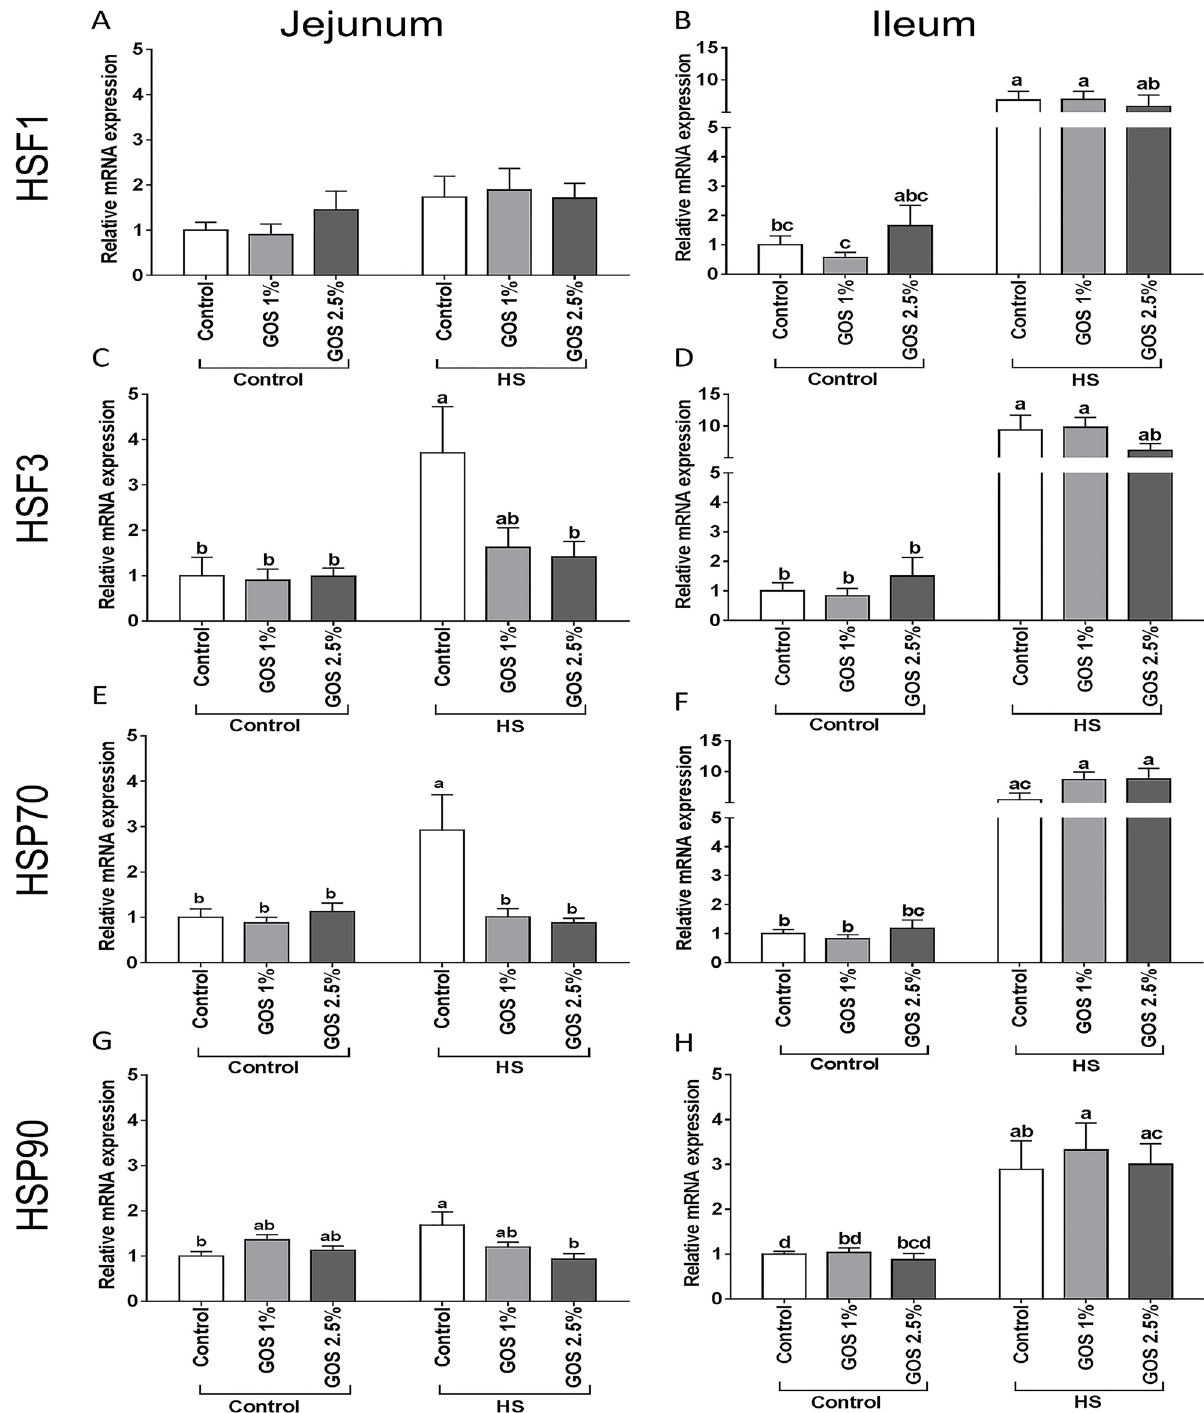
Fig 1. The effect of heat stress exposure on the mRNA expression of HSFs and HSPs in jejunum and ileum of chickens fed a control or GOS diet. Chickens fed a control or GOS (1 or 2.5%) diet for 6 days before being exposed to either control or heat stress conditions for 5 days. mRNA expression levels of HSF1 (A, B), HSF3 (C, D), HSP70 (E, F) and HSP90 (G, H) were evaluated in jejunum (A, C, E, G) and in ileum (B, D, F, H) by qRT-PCR. Results are expressed as relative mRNA expression (fold of control, normalized to β -actin) as mean ± SEM, n = 6 – 10 animals/experimental group. Different lower-case letters denote significant differences among